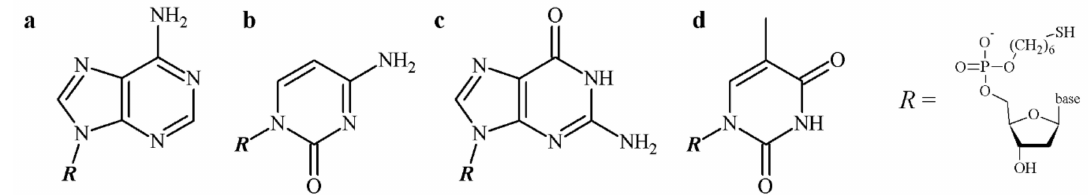
Figure 2. The structure of thiolated mononucleotides of: ( a ) adenine, ( b ) cytosine, ( c ) guanine and ( d )